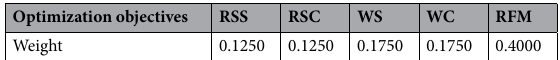
Optimization objectives